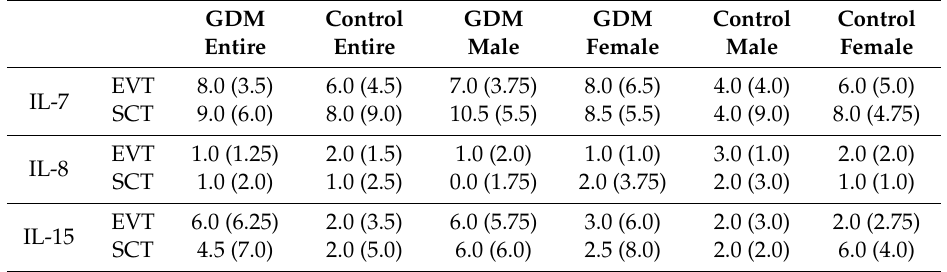
Table 1. This table shows the median IRS values for both main groups and each subgroup in EVT and SCT. Furthermore, the respective interquartile range is indicated in the SCT. Furthermore, the respective interquartile range is indicated in the brackets.